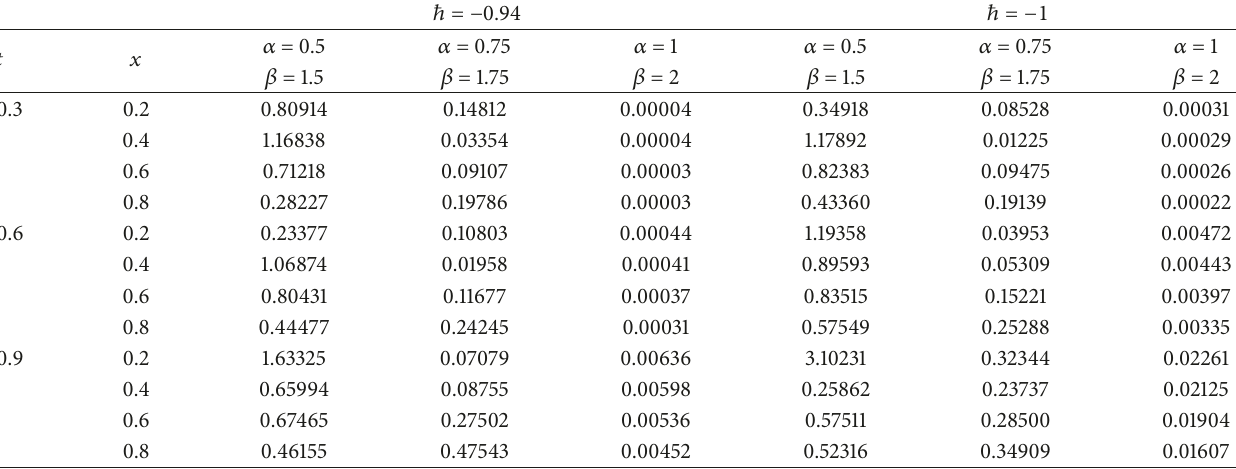
Table 3: The absolute errors for case A in Example 2.